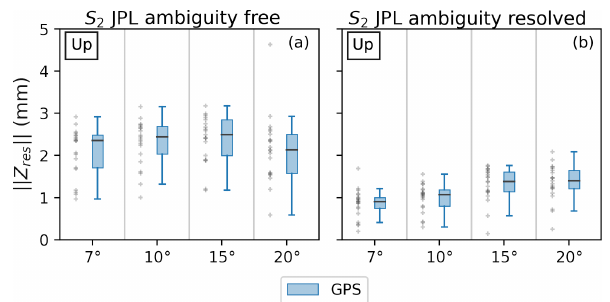
Figure 10. GPS S 2 up constituent’s (cid:107) Z res (cid:107) change with elevation cutoff angle computed with JPL products floating AR (a) and inte- ger AR (b) . Grey crosses are as per Fig. 3. As seen, AR helps in removing the bias and decreases the (cid:107) Z res (cid:107) distribution